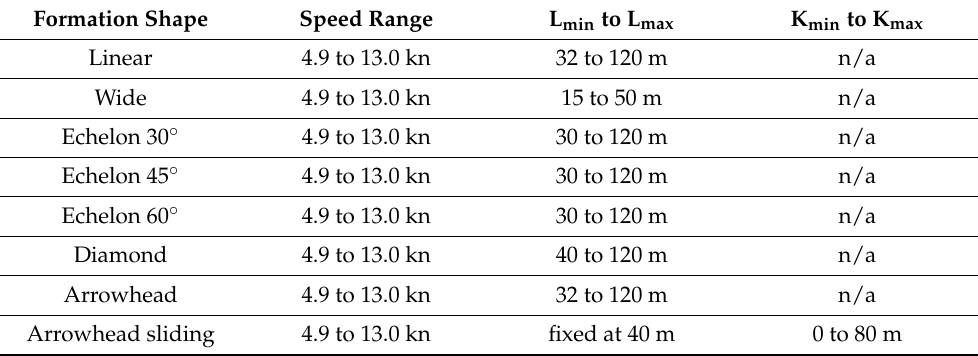
Table 3. Ranges of tested speeds, L values (distances between ships) and K value (position of outermost ships with respect to the leading tug in the arrowhead-shaped